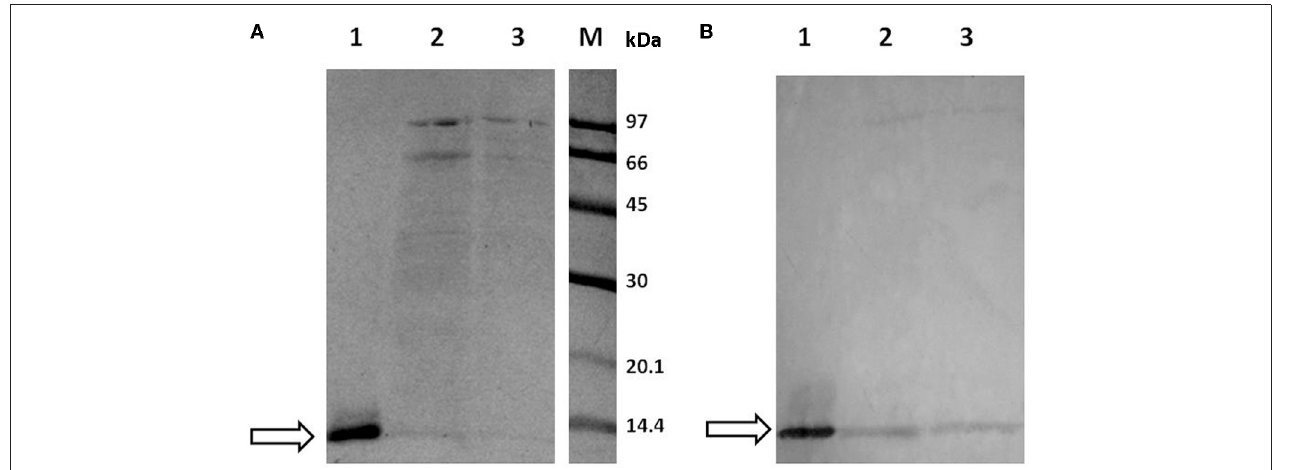
FIGURE 1 | Analysis of Stx2 holotoxin by SDS-PAGE and Western blot. (A) SDS-PAGE (12.5% acrylamide, under reducing